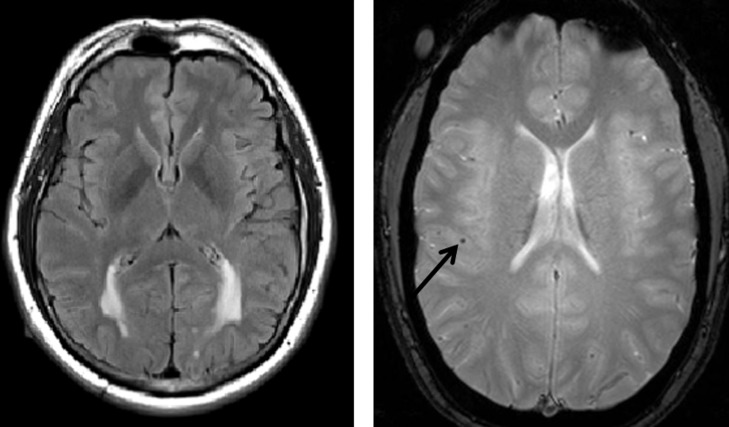
Examples of WMH and microbleeds.Left: T2-weighted FLAIR images from a mutation carrier with prominent posterior WMH, approximately 5 years prior to symptom onset. Right: example of microbleed (arrow) on a gradient echo MRI scan.